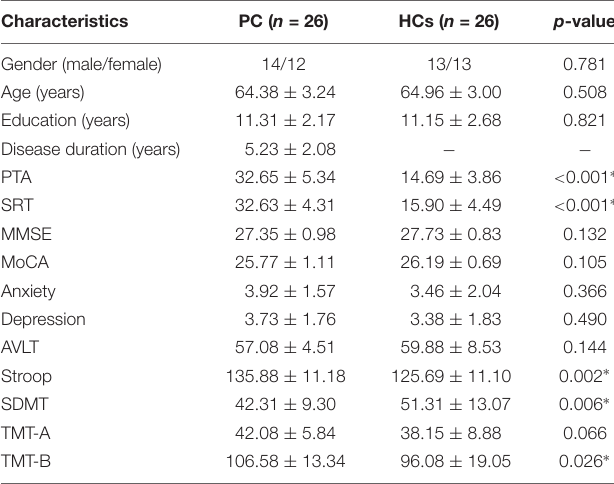
TABLE 1 | Participants’ demographic and clinical